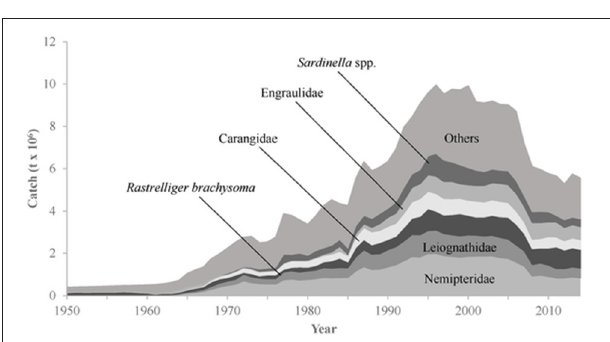
FIGURE 5 | Taxonomic composition of total reconstructed catches for Thailand, 1950–2014. Major taxonomic groups are shown only. “Others” includes 79 additional taxonomic